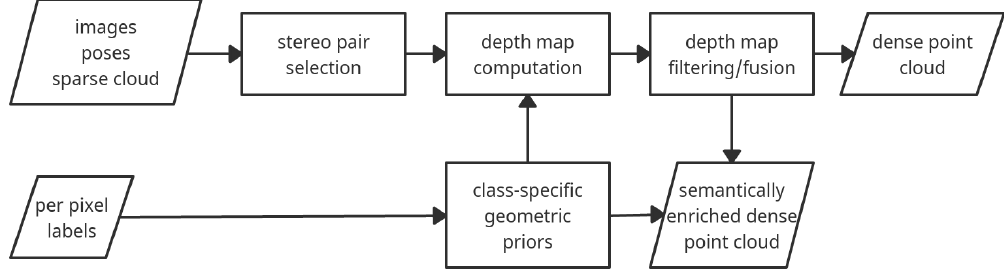
Figure 1. Overview of the proposed method leveraging semantic information into the 3D dense point cloud reconstruction. Per pixel labels are used to generate class specific geometric priors to support depth map computation in problematic textureless areas and produce a more complete point cloud enriched also with the semantic